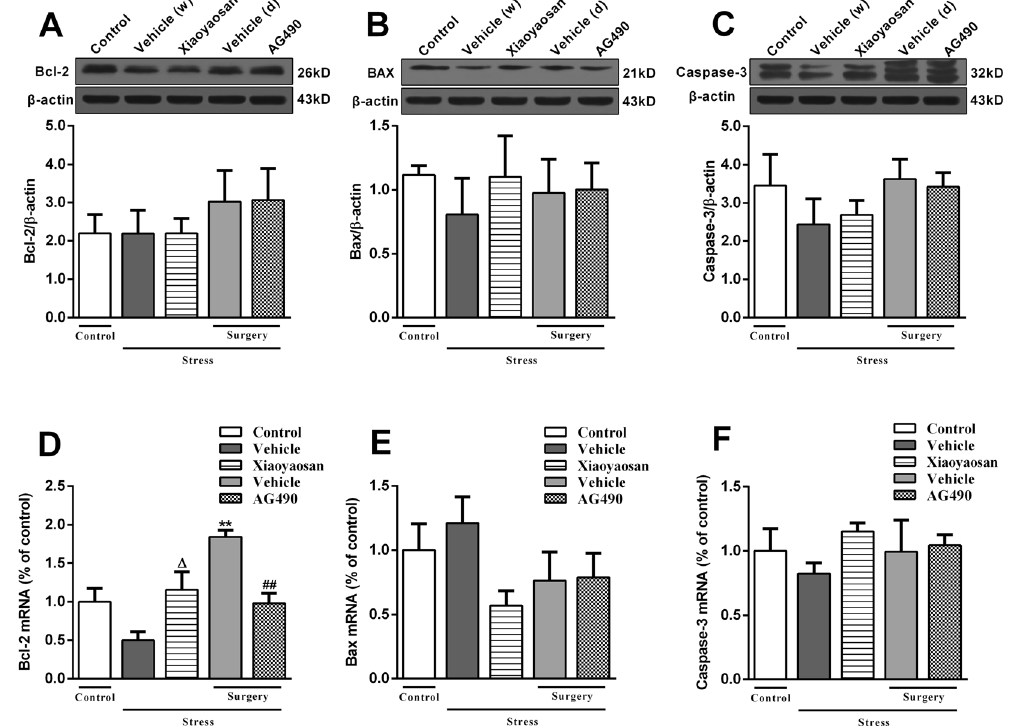
Figure 6. Effects of Xiaoyaosan on the expression of the Bcl-2, Bax and Caspase-3 proteins and mRNAs in the rat hippocampus. ( A ) Expression of the Bcl-2 protein in the rat hippocampus. ( B ) Expression of the Bax protein in the rat hippocampus. ( C ) Expression of the Caspase-3 protein in the rat hippocampus. ( D ) Expression of the Bcl-2 mRNA in the rat hippocampus. ( E ) Expression of the Bax mRNA in the rat hippocampus. ( F ) Expression of the Caspase-3 mRNA in the rat hippocampus. Values are presented as the means ± SEM from 3–4 rats per group for the determination of the expression of the Bcl-2, Bax and Caspase-3 proteins and from 5 rats per group for the measurement of mRNA expression in the rat hippocampus. ** P < 0.01 versus the control group. Δ P < 0.05 versus the vehicle (distilled water) group. ## P < 0.01 versus the vehicle (dissolvent)